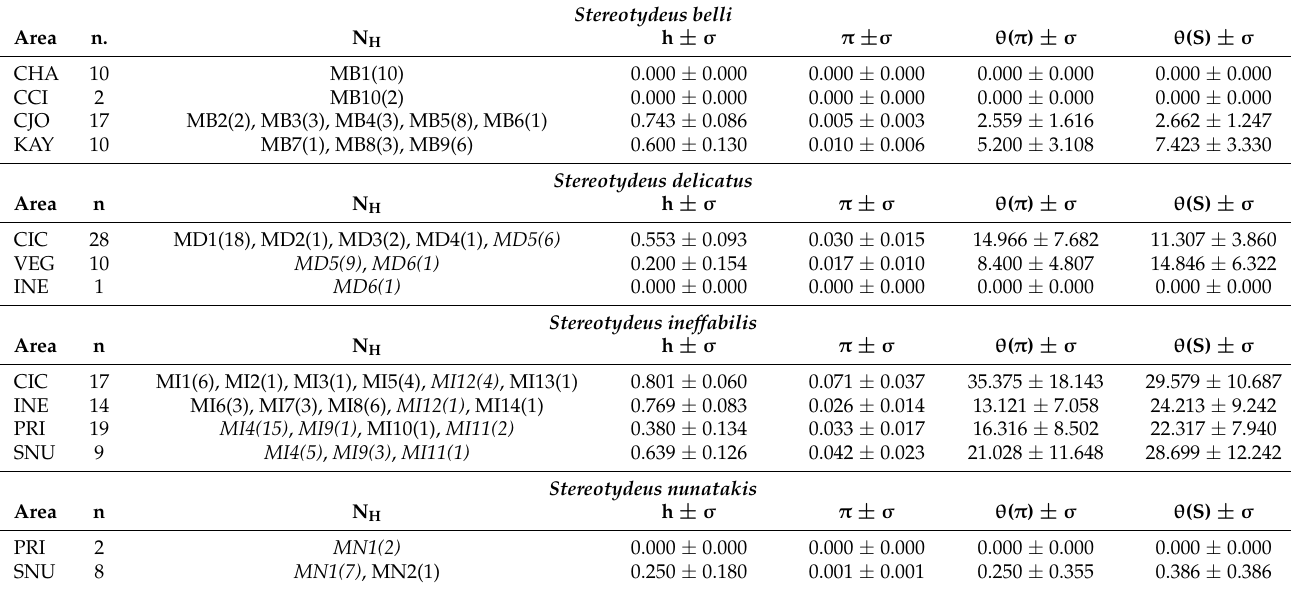
Table 9. Population genetic parameters for cox1 in S. belli , S. delicatus , S. ineffabilis and S. nunatakis sampled across Victoria Land (Area). n , number of individuals; N H , number of haplotypes within the populations and their frequencies; h , haplotype diversity; π , nucleotide diversity; θ ( π ) , mean number of pairwise differences; θ (S), mean number of segregating sites; haplotypes shared between populations are indicated in italics (see Table 5 for details).